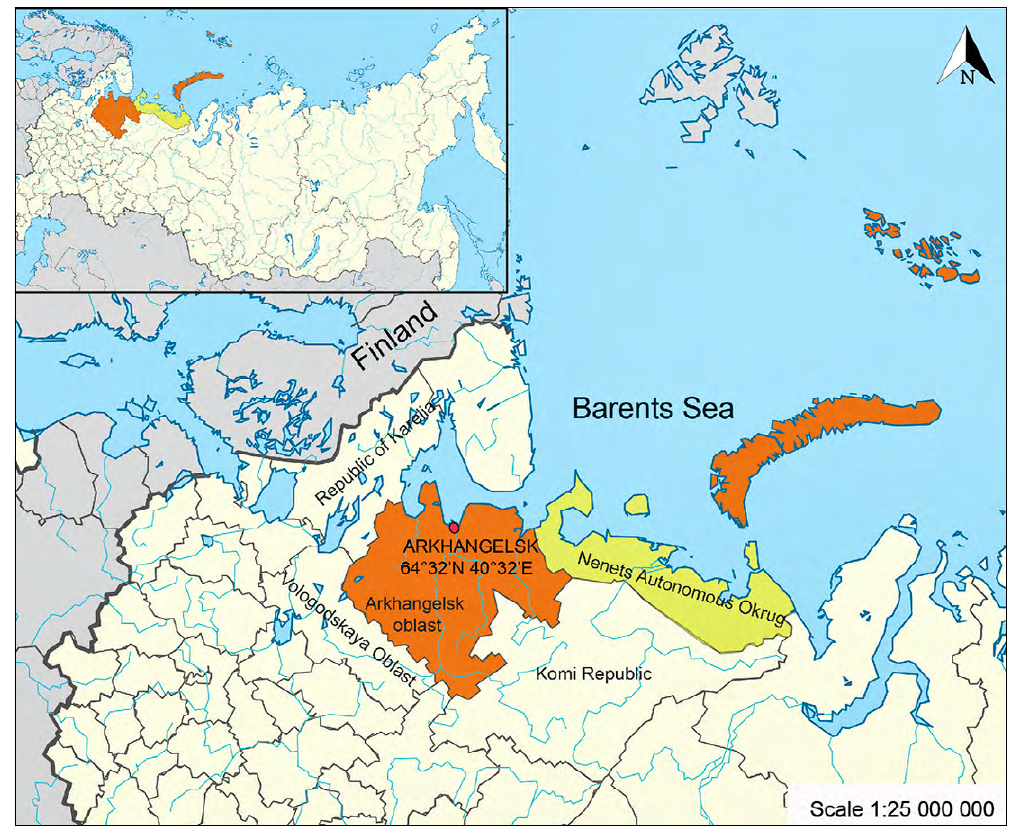
Figure 1. Location of the study area - Arkhangelsk region of Russian Federation: Archangelsk province,